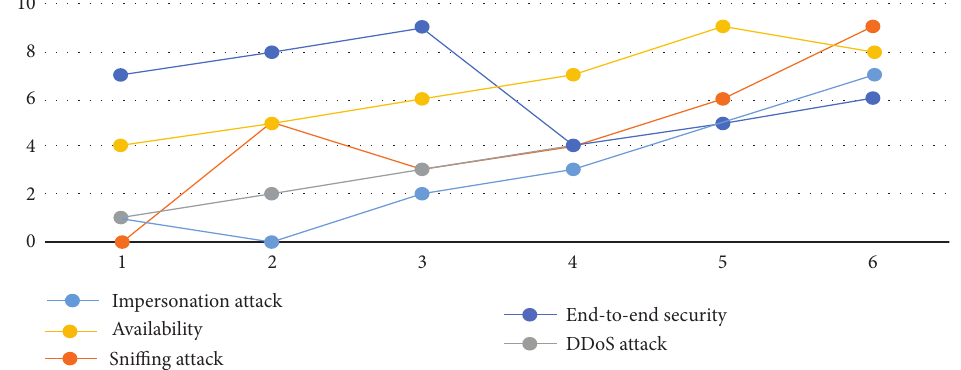
Figure 3: Static key management schemes versus attacks for UDP data.